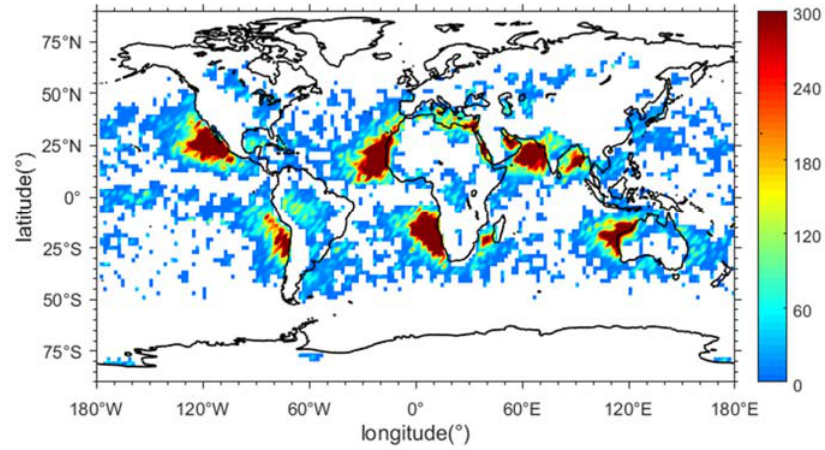
Figure 4. The number of the trapping layer concurrences within the 2_deg by 2_deg grid.